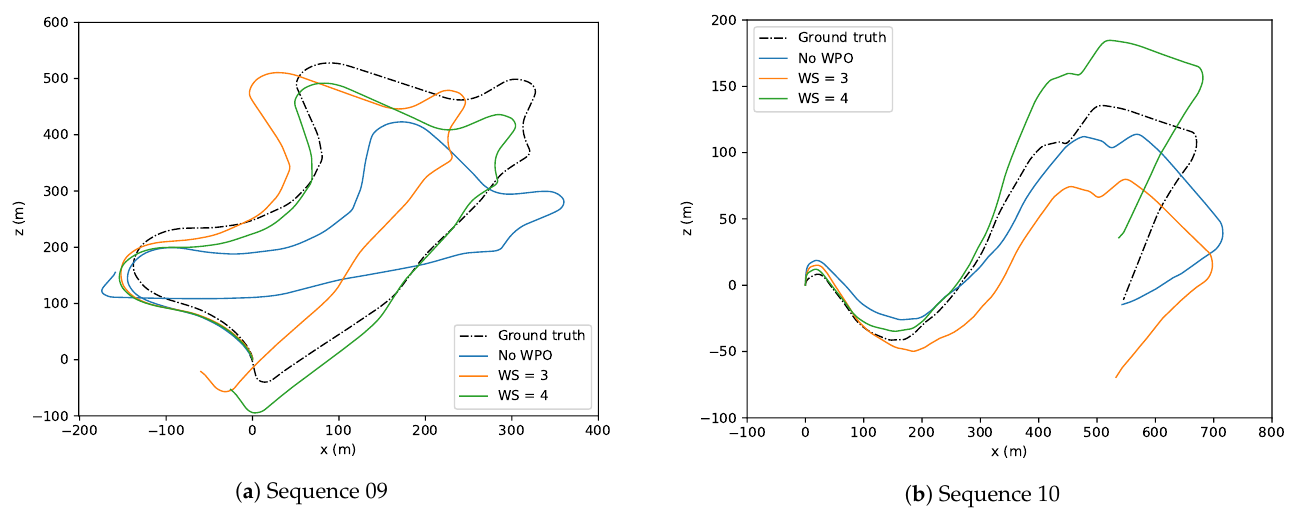
Figure 5. Trajectories of sequences 09 ( a ) and 10 ( b ) under different window sizes ( WS ) . X and Y -axis represent motion along the Z (forward) and X (left/right) axis of the vehicle in the vehicular